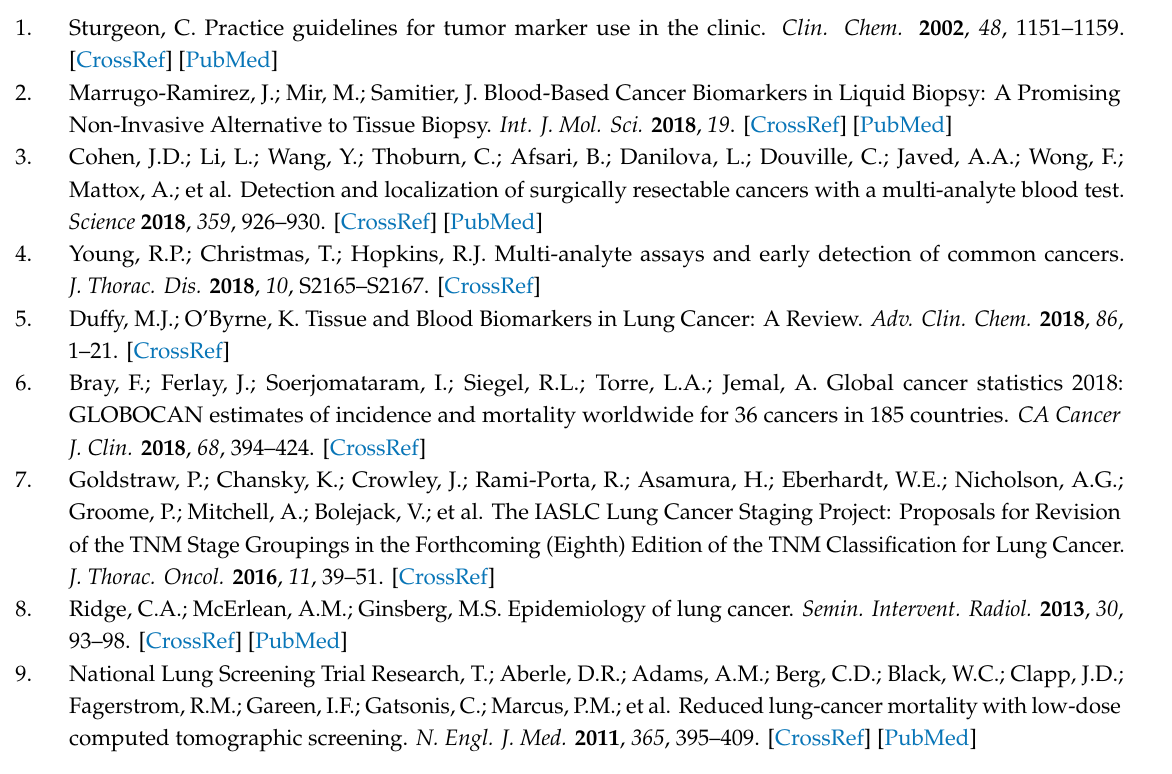
included in the diagnostic panel, Figure S4: Forest plot showing the NPV values of all the possible sub-combinations of the 6-protein panel, Figure S5: Forest plot showing the PPV values of all the possible sub-combinations of the 6-protein panel, Figure S6: Forest plot showing the sensitivity values of all the possible sub-combinations of the 6-protein panel, Figure S7: Forest plot showing the specificity values of all the possible sub-combinations of the 6-protein panel, Figure S8: Forest plot showing the AUC values of all the possible sub-combinations of the 6-protein panel, Table S1: Patient and healthy donor demographics, Table S2: List of target proteins consisting of 323 potential biomarker candidates (in bold) and 28 typical plasma proteins, and their surrogate peptides and precursors m / z, Table S3: List of the 229 proteins di ff erentially expressed in plasma from lung cancer patients and healthy donors, as measured by LC-PRM, Table S4: Protein combinations selected more than 10 times in LASSO as the most predictive ones in distinguishing lung cancer from healthy samples, and the percentage of appearance of individual proteins in 4,500,000 bootstrapped datasets, Table S5: The lung cancer prediction of the 6-protein panel in the training cohort classified by lung cancer type, stage, grade and by smoking history, Table S6: The lung cancer prediction of the 6-protein panel in the validation cohort classified by lung cancer type, stage, grade and by smoking history, Table S7: Clinicopathological features of lung cancer patients in the training (T) and in the validation (V) cohorts, Table S8: Clinicopathological features of healthy donors in the training (T) and in the validation (V) cohorts, Text S1: Discovery study summary, Text S2: Supplementary Materials and